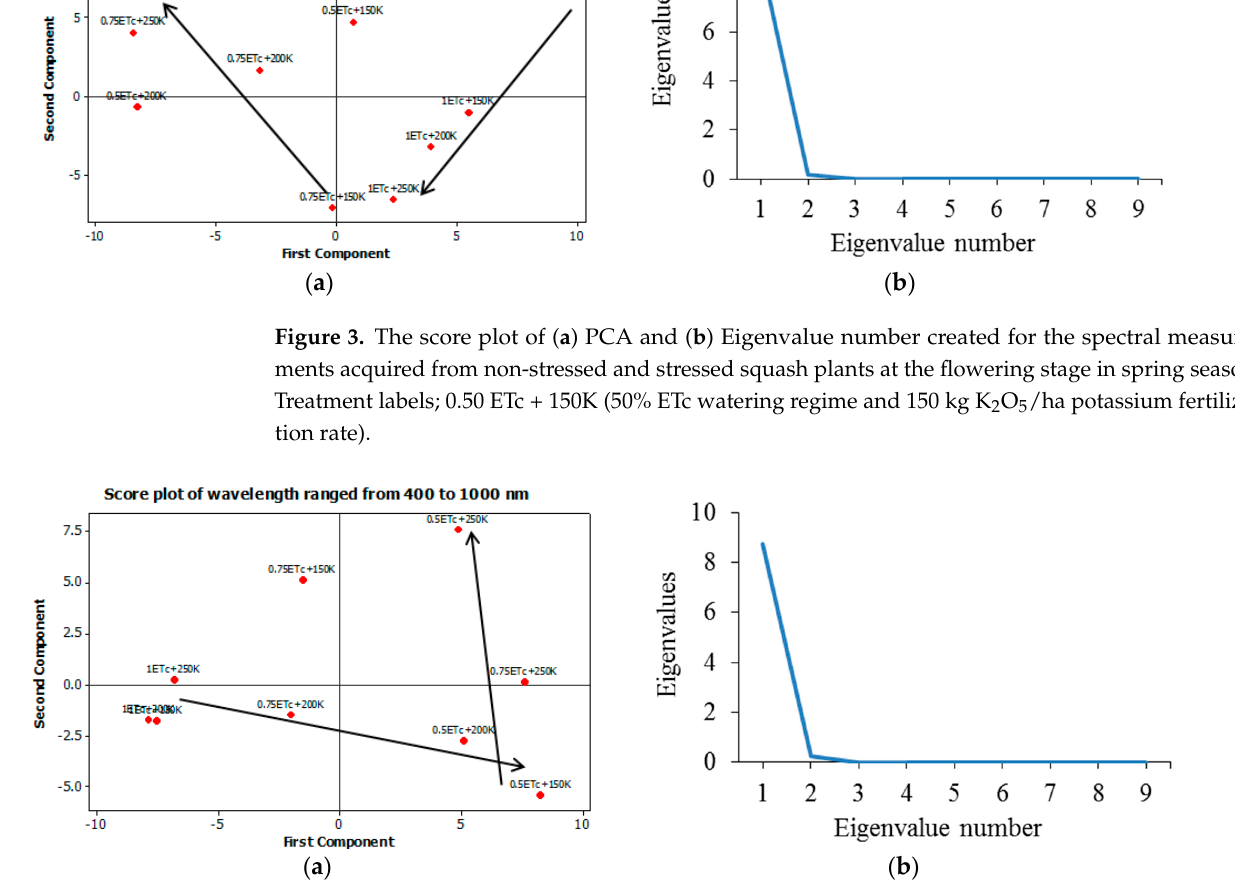
Figure 4. The score plot of ( a ) PCA and ( b ) Eigenvalue number created for the spectral measurements acquired from non-stressed and stressed squash plants at the flowering stage in fall season. Treatment labels; 0.50 ETc + 150K (50% ETc watering regime and 150 kg K 2 O 5 /ha potassium fertilization rate).